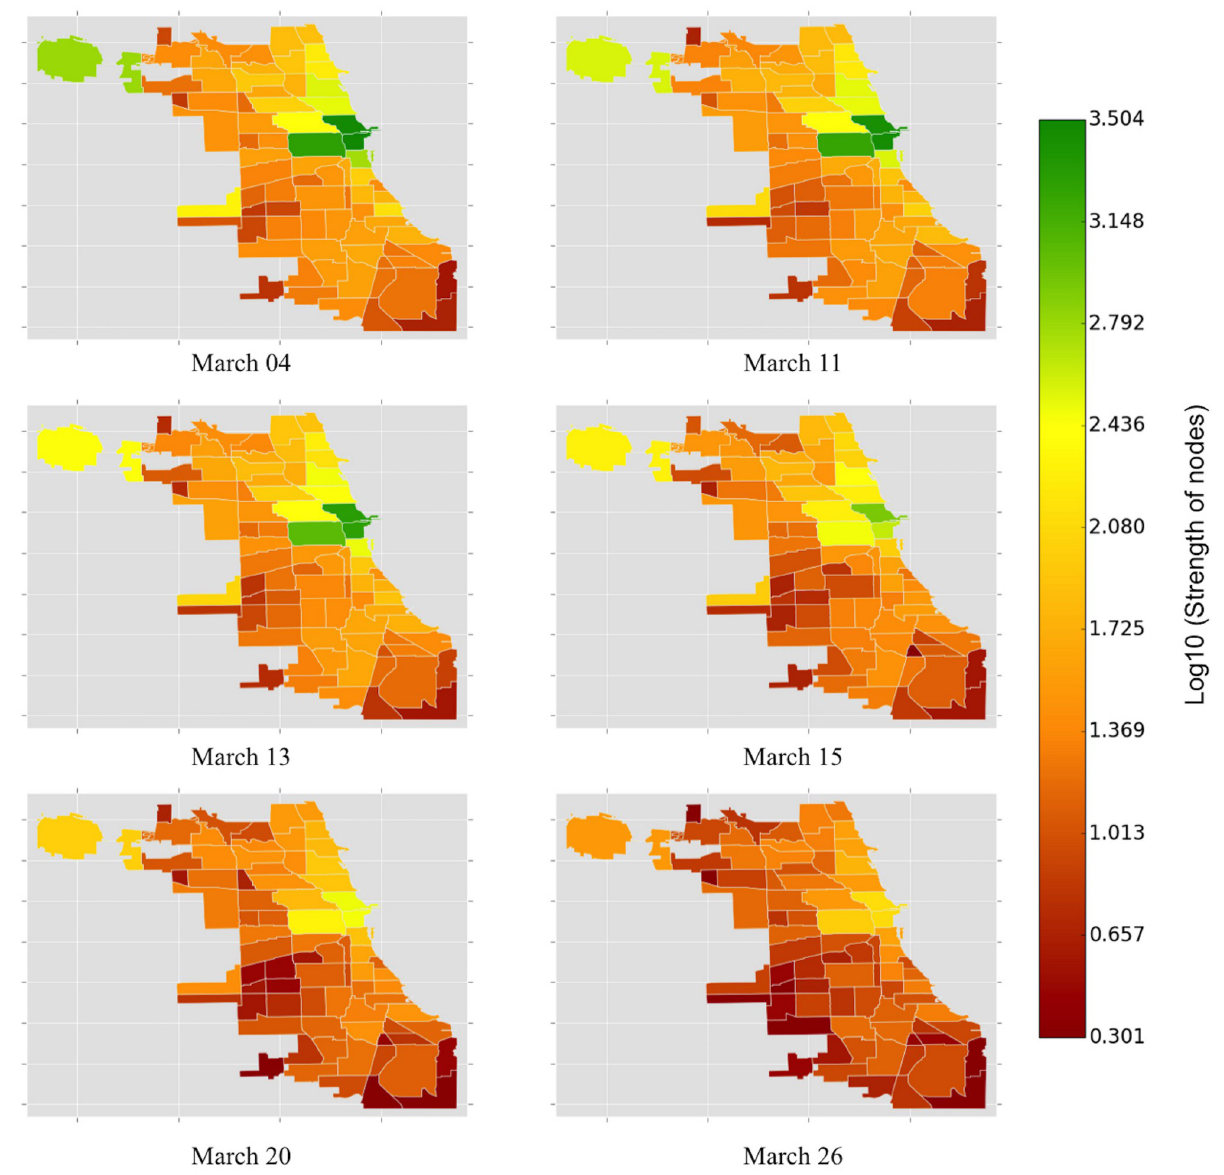
Fig 6. The color of the Chicago community areas is proportional to the strength of the nodes (community areas) (log10 transformed). On March 04, we observed higher values of node strength in Near North Side, West Town, Near West Side, Loop, and Chicago O’Hare. The node strength of Chicago O’Hare keeps decreasing from March 11, 2020, suggesting lesser movement of domestic and international travelers. The color of the zones neighboring the Loop shifts towards the red spectrum from March 15, 2020. Interestingly, the southern neighborhoods of Chicago do not witness any significant change in node